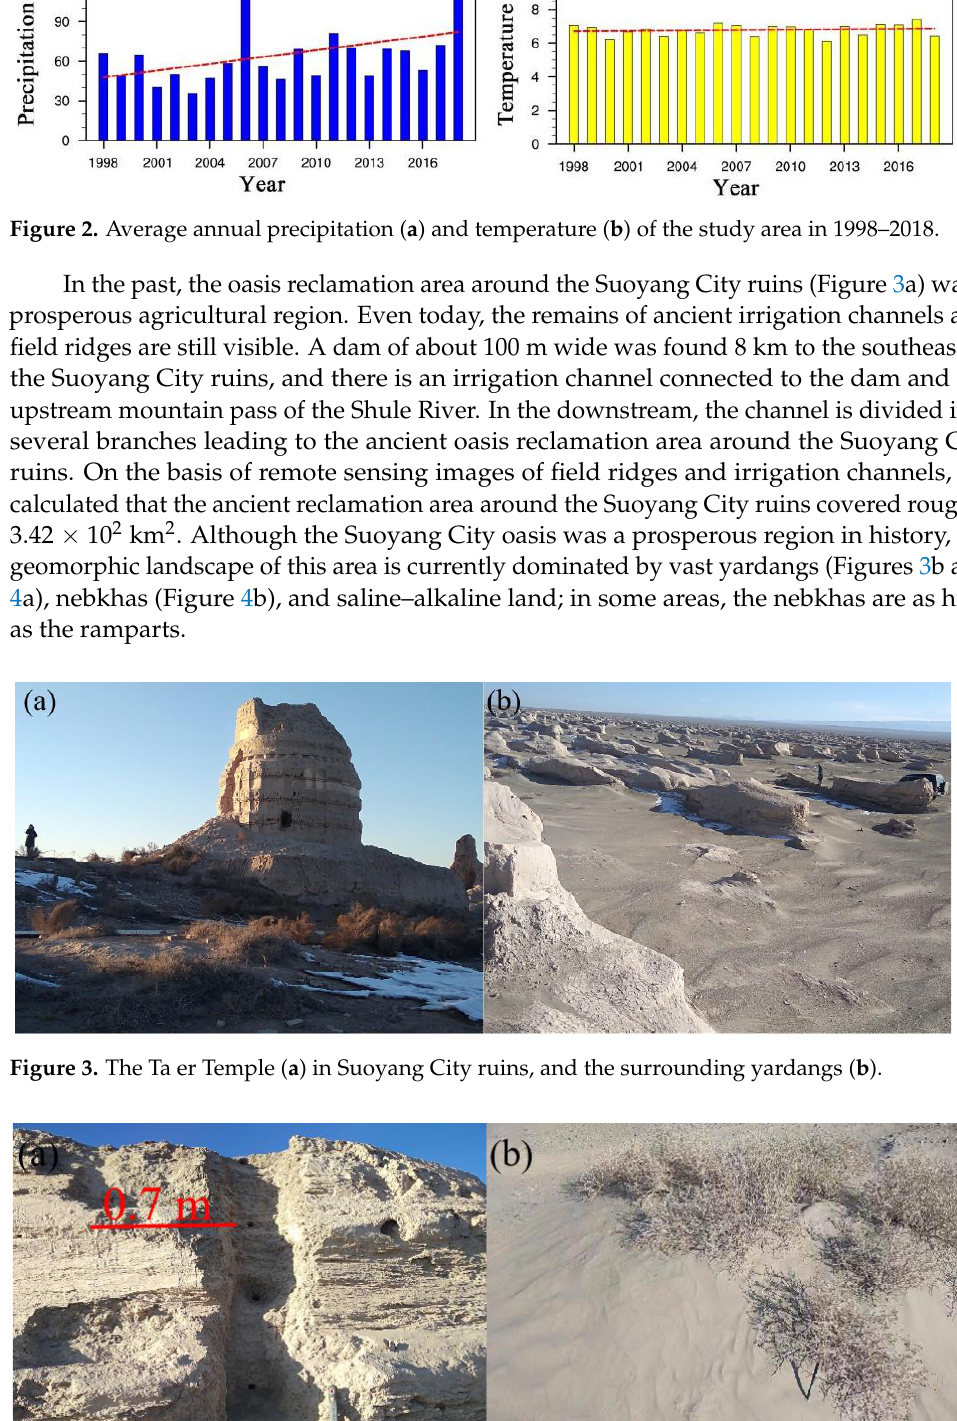
Figure 4. The dating sample profile ( a ) and nebkhas ( b )surrounding the Suoyang City